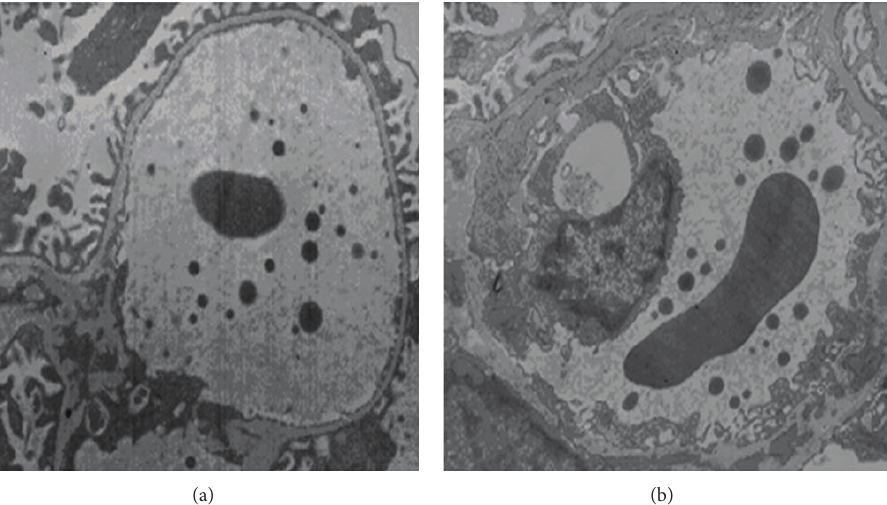
Figure 4: Indirect examination of the thickness of the glomerular endothelial surface layer. Kidneys were fixed in glutaraldehyde after the addition of Intralipid particles to the circulation. (a) Control and (b) diabetic